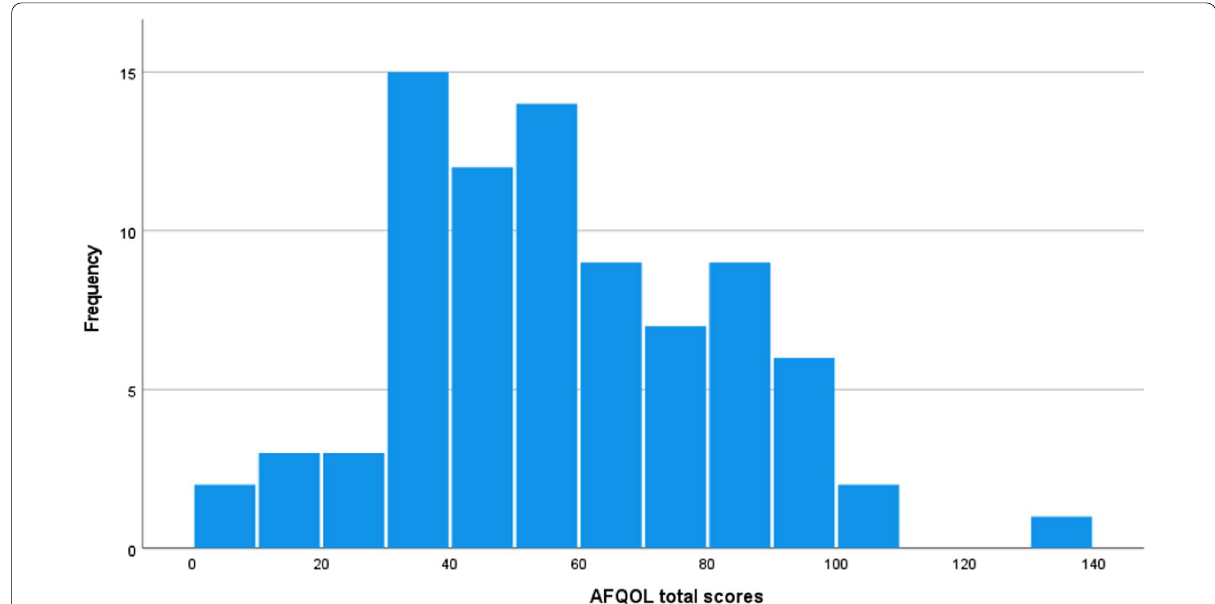
Fig. 3 Distribution of the AFQOL total